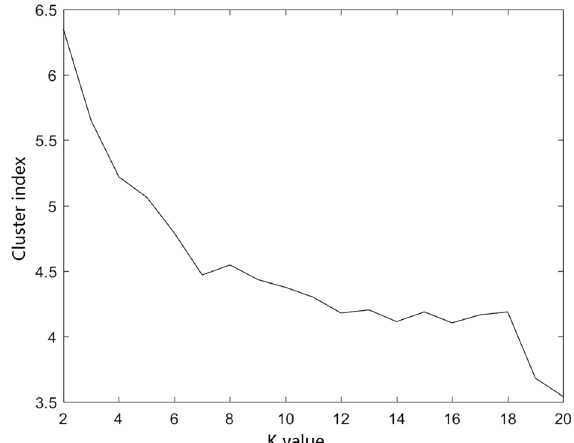
Fig. 4 Effect of K-means clustering algorithm